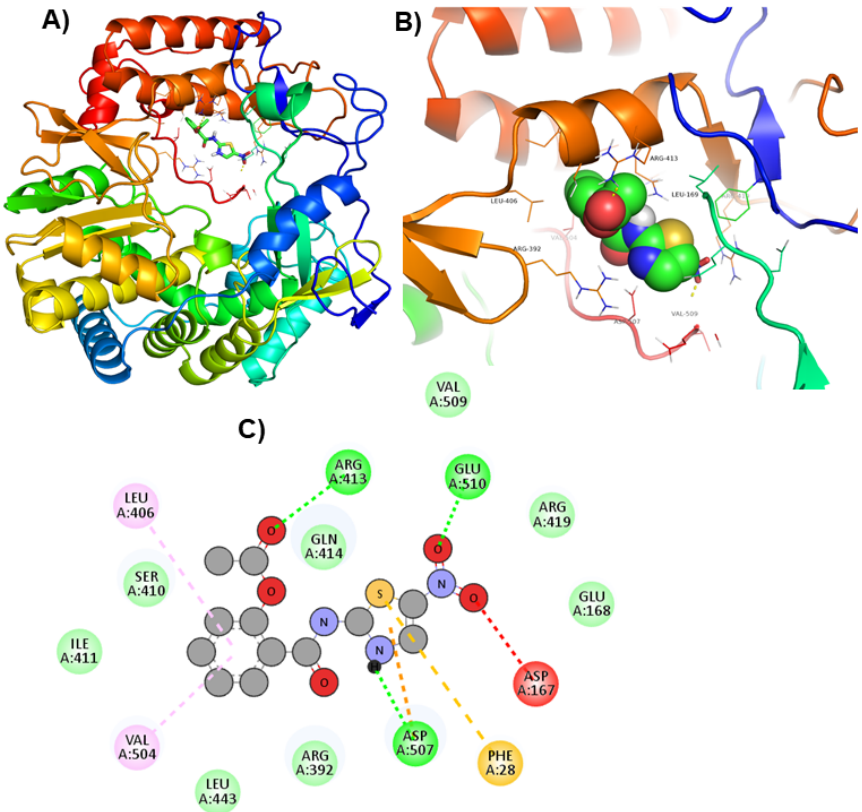
Figure 4. Visualization of PPNDS in RdRp's active site. 3D views of whole protein and ligand interactions ( A ), 3D views of interacting residues of the RdRp active site with PPNDS ( B ), and 2D views of the RdRp residue interacting with PPNDS ( C ).